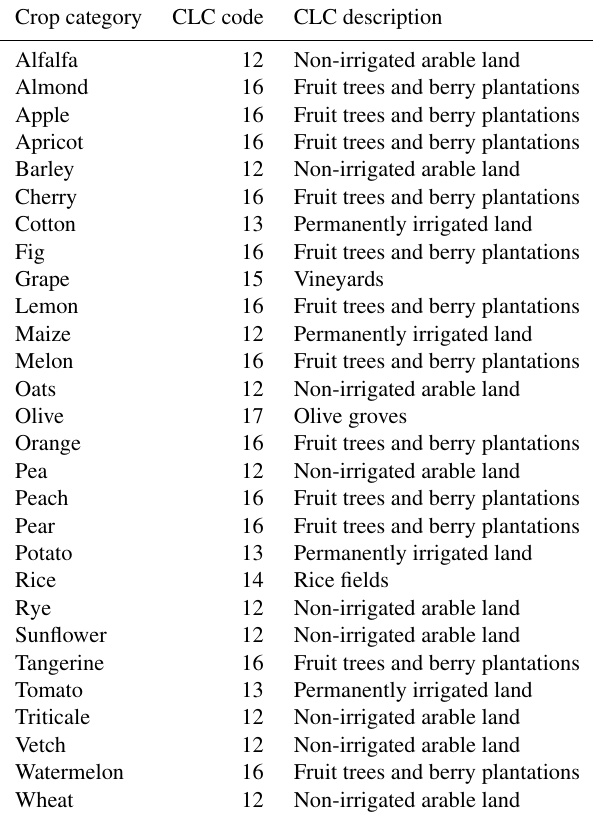
Table A1. Relationship between crop types and CORINE Land Cover (CLC) land use